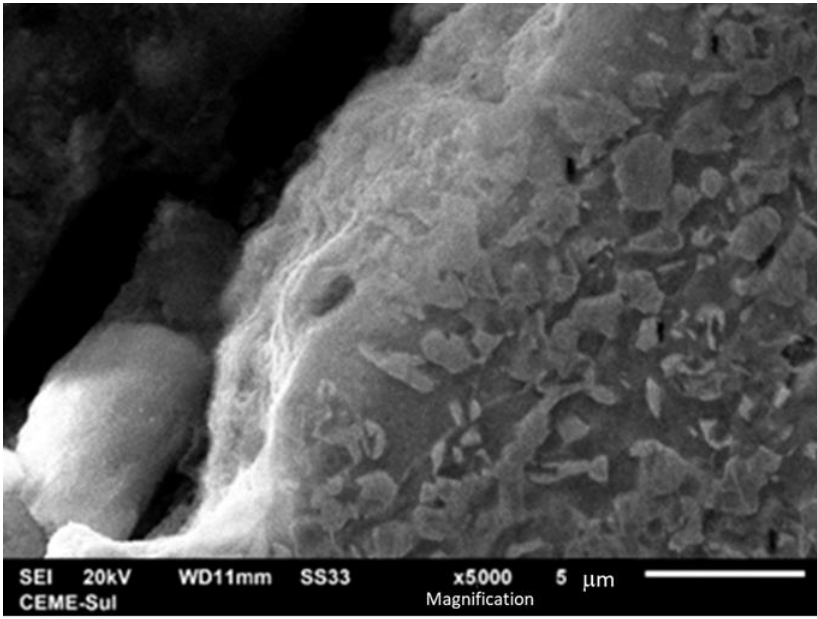
Figure 10. Formation of voids around the martensite phase (source : author).